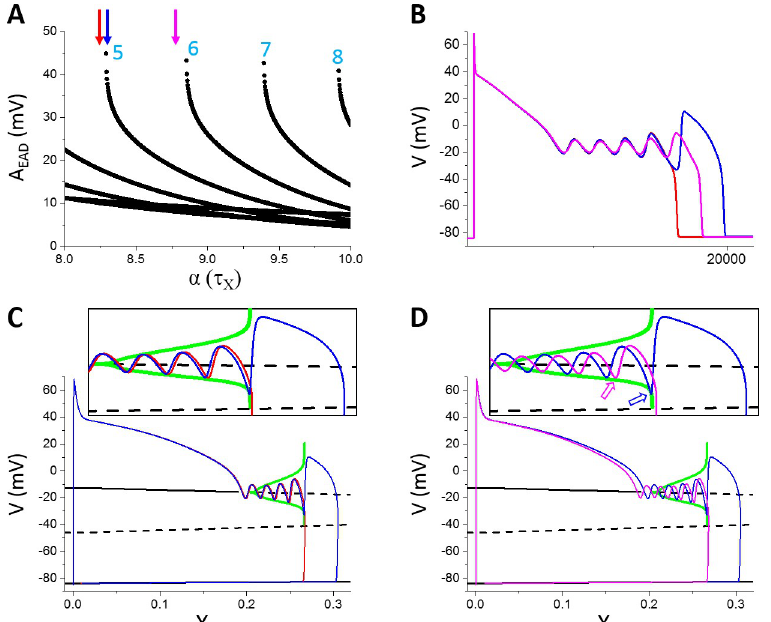
Fig 4. Linking the dual Hopf-homoclinic bifurcation to the EAD amplitude behavior. A . A EAD versus fold change ( α ) of τ X . B . APs correspond to the parameters indicated by the arrows with the same colors. Red: α = 8.24; Blue: α = 8.29; Magenta: α = 8.78. C . Bifurcation in the fast subsystem, the same as in Fig 2A except that I Na was present. The blue and red traces are V versus X for the corresponding blue and red APs in B. Inset is the blowup of the EAD window. D . Same as C but for the blue and magenta APs in B. Open arrows in the inset mark the takeoff location of the 5 th EAD with respect to the homoclinic bifurcation point. Note that both APs exhibit 5 EADs but the ones in the magenta AP take off at smaller X